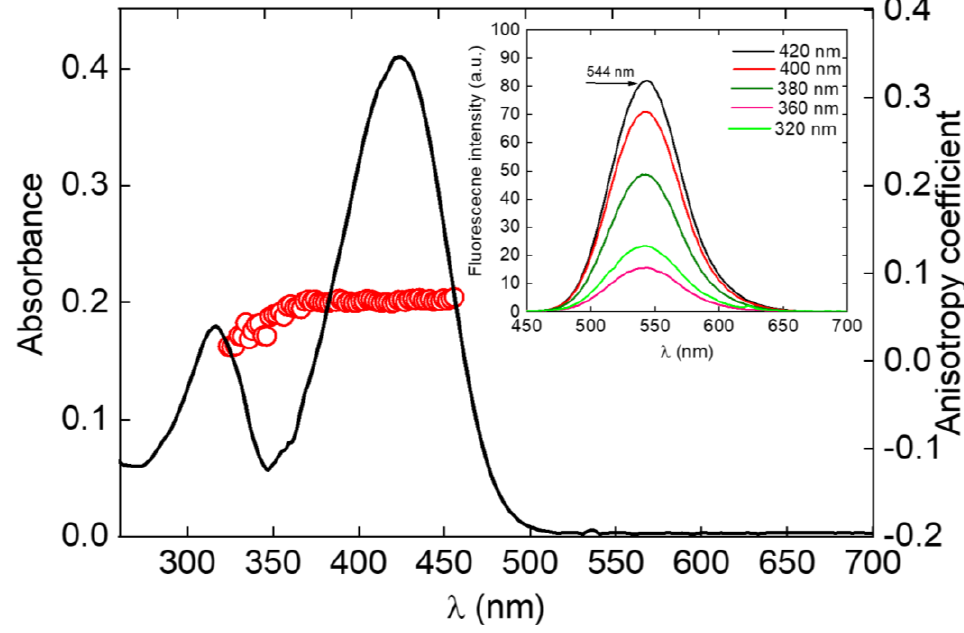
Figure 4. Fluorescence anisotropy (red circles) for compound ChN(CH3)2 . The inset displays the fluorescence spectrum for different excitation wavelengths.